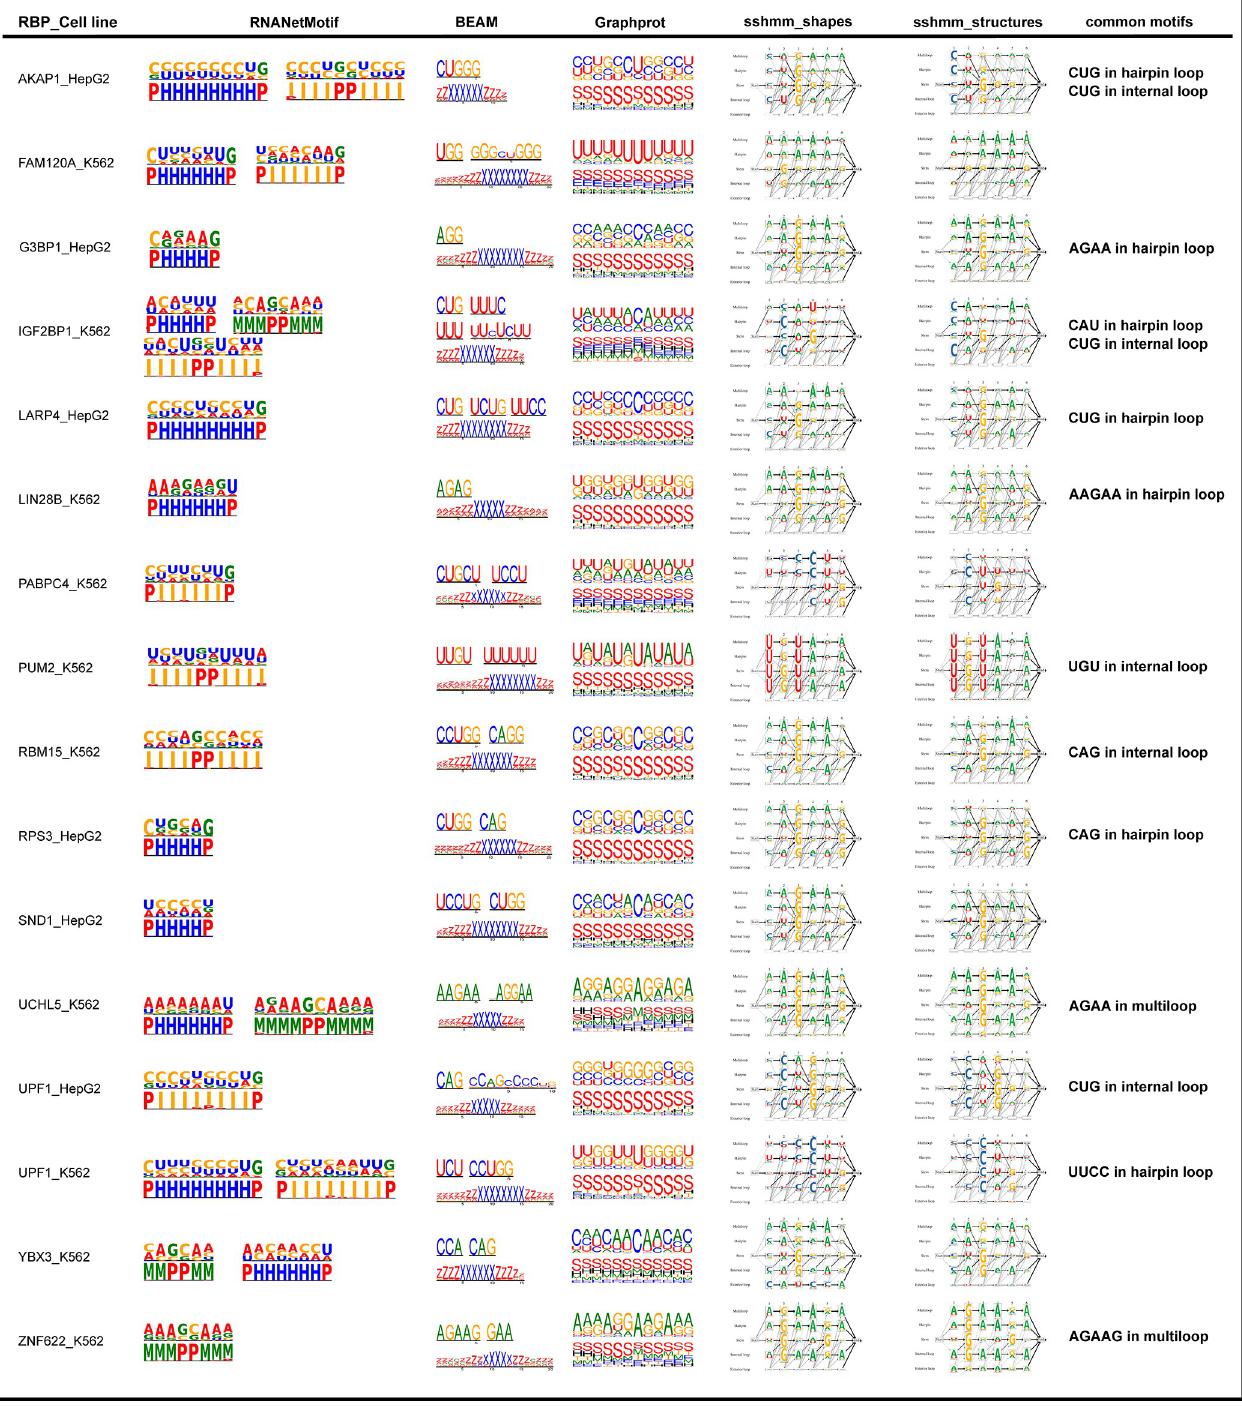
Fig 8. Comparison with other sequence-structure motif predictors on 16 eCLIP